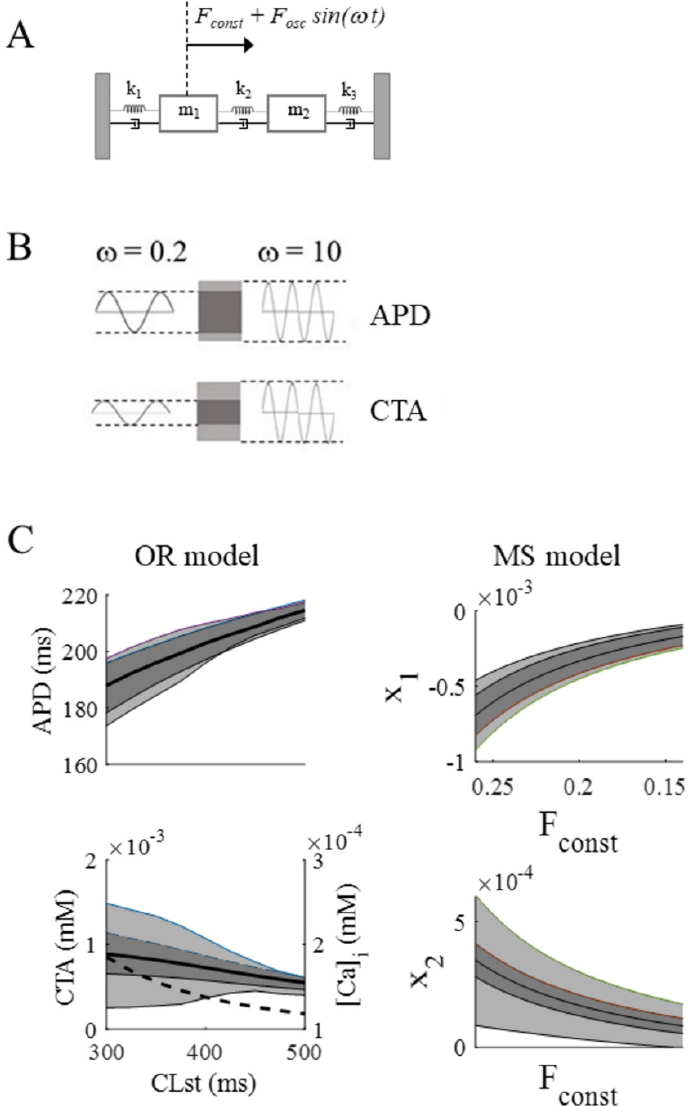
Figure 10. MS model reproduces both rate dependence and ω dependence of oscillations. The mechanical model, modified by making the stiffness k 1 linearly dependent on F const (panel ( A )), was forced according to Equation (7), with 0.14 < F const < 0.26, at low (0.2) and high (10) ω values, while the OR model was paced according to Equation (1) at the same ω values. Results of simulations at low and high ω are reported as dark and light grey regions, respectively (scheme in panel ( B )). Left column of panel ( C ) shows the average value (black line) and the oscillation amplitude of APD (top) and CTA (bottom) as explained in panel B, for BCL ranging from 300 to 500 ms. Superimposed in the bottom panel (broken line), the end-diastolic value of intracellular calcium concentration. On the right column, x 1 and x 2 oscillations when the MS model was forced as explained